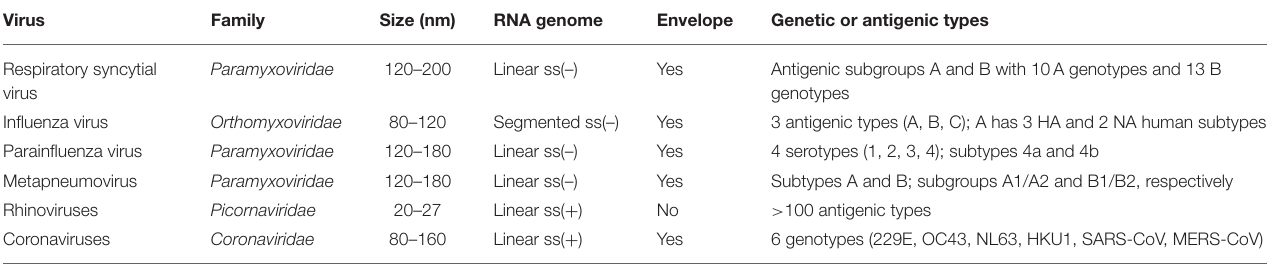
TABLE 1 | Taxonomy and virologic properties of the major human respiratory RNA viruses a .